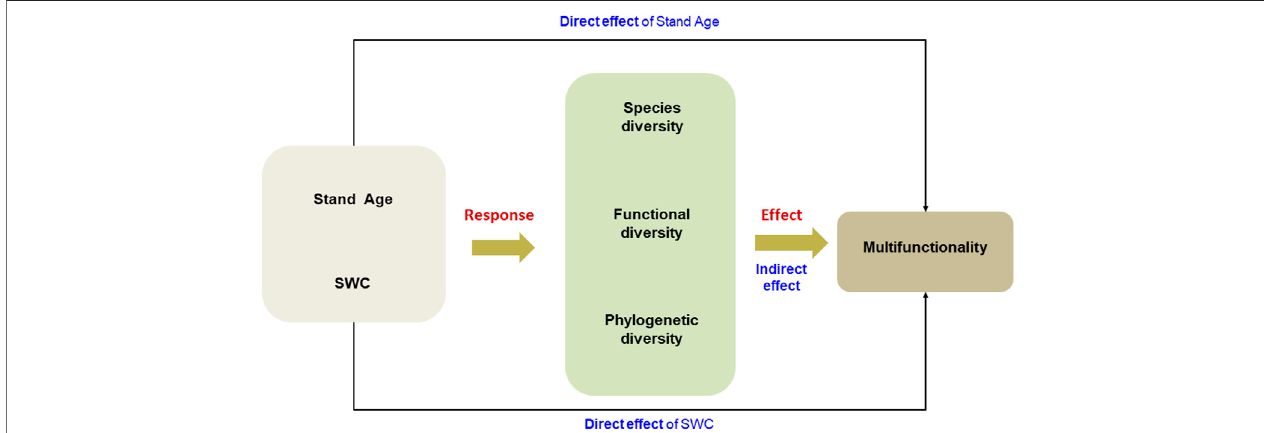
FIGURE 1 | A conceptual model revealing the impact of soil water condition and diversity indices on EMF along successional stages of the semi-arid grassland on the Loess Plateau. SWC, soil water content.